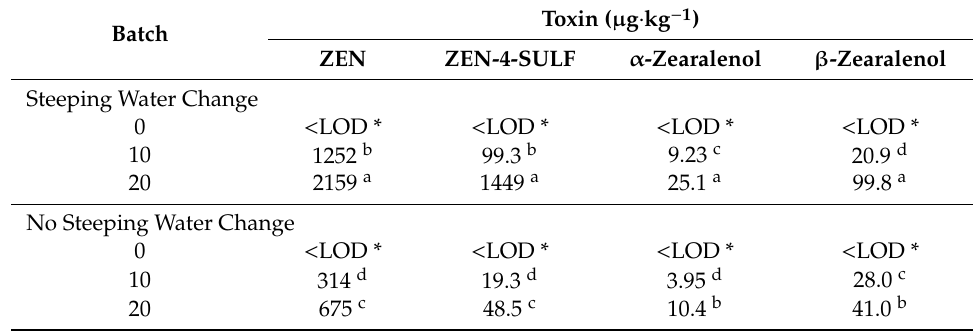
Table 4. Concentrations of ZEN (zearalenone) and its derivatives (zearalenone-4-sulphate) in malt samples.